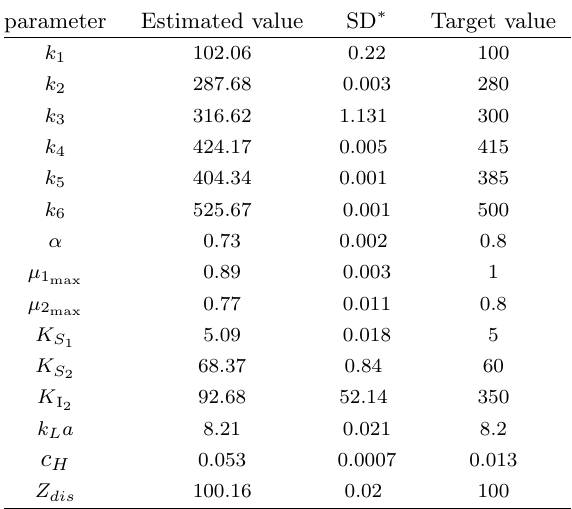
Table 7: The evaluation on the validation based on RMSE for the simulated model